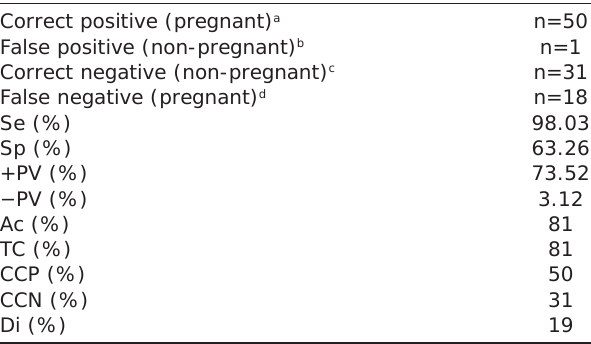
Table-3: Se, Sp, +PV, − PV, Ac, TC, CCP, CCN and Di of PD by TU in Sahelian